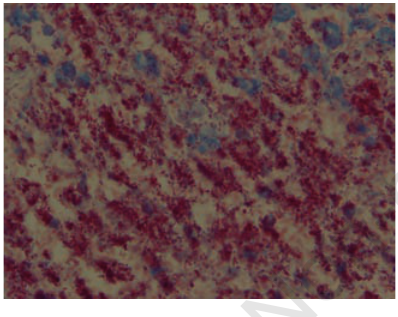
Figure 2. Lymph node, acid fast positive bacilli (Hematoxylin &Eosin ×400).